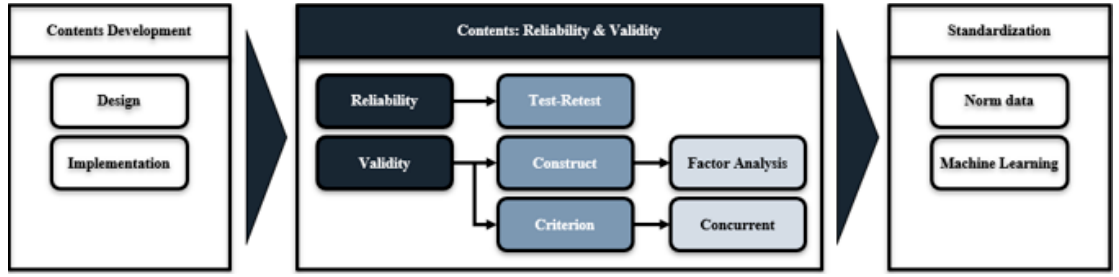
Figure 3. Clinical trial process for the computer-based dementia assessment contents (Co-Wis).